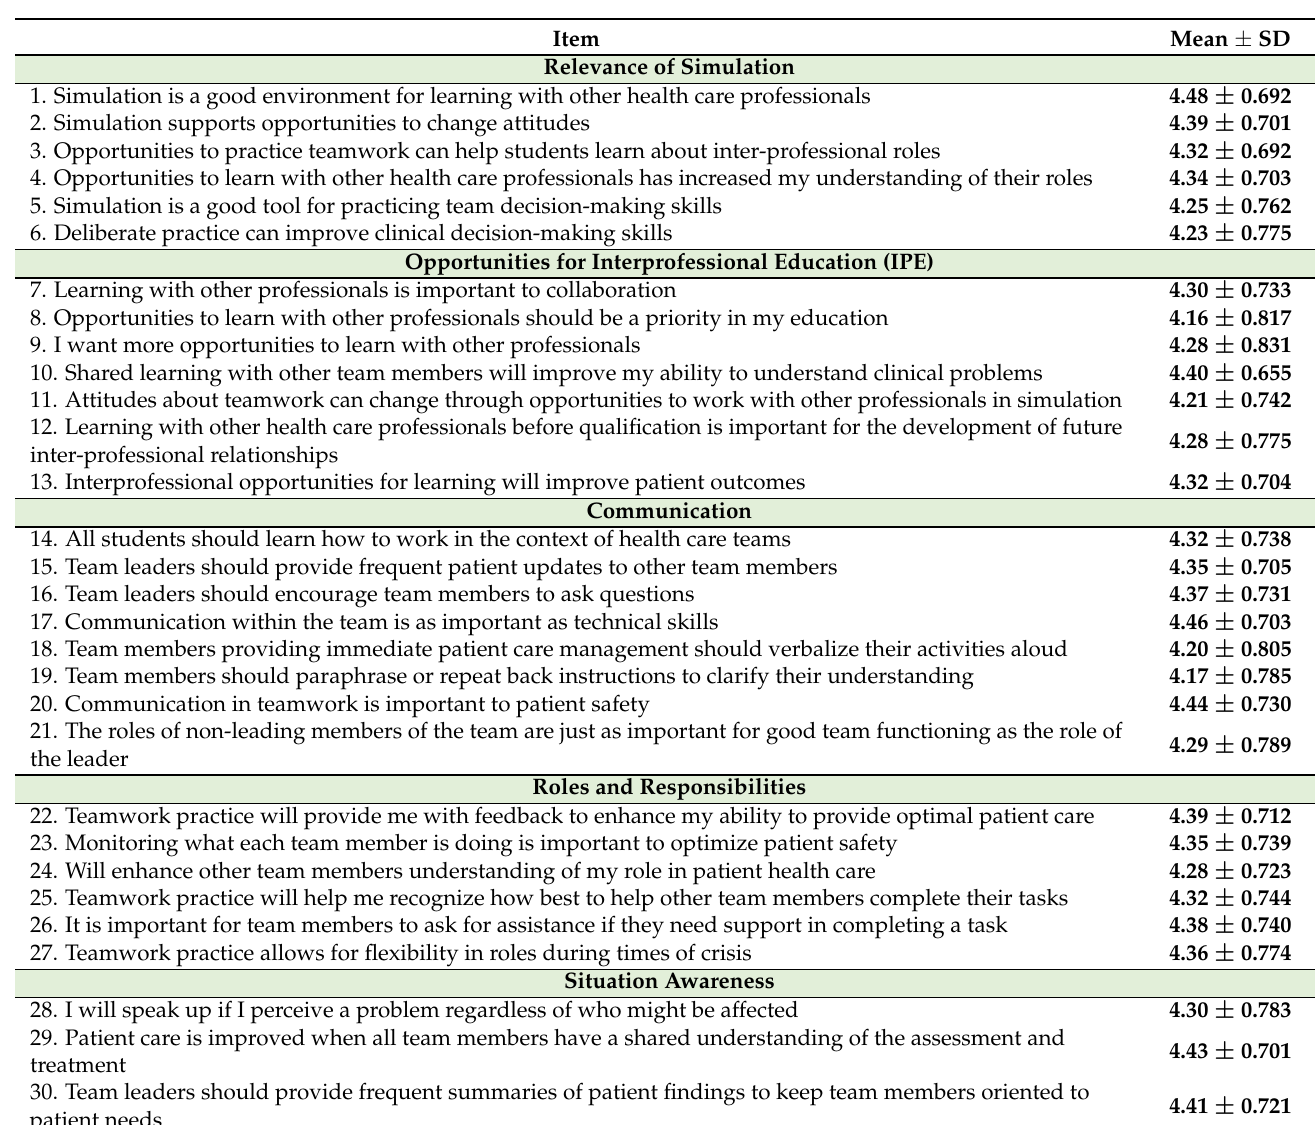
Table 2. Attitudes, perceptions, and experiences using educational simulation in Saudi